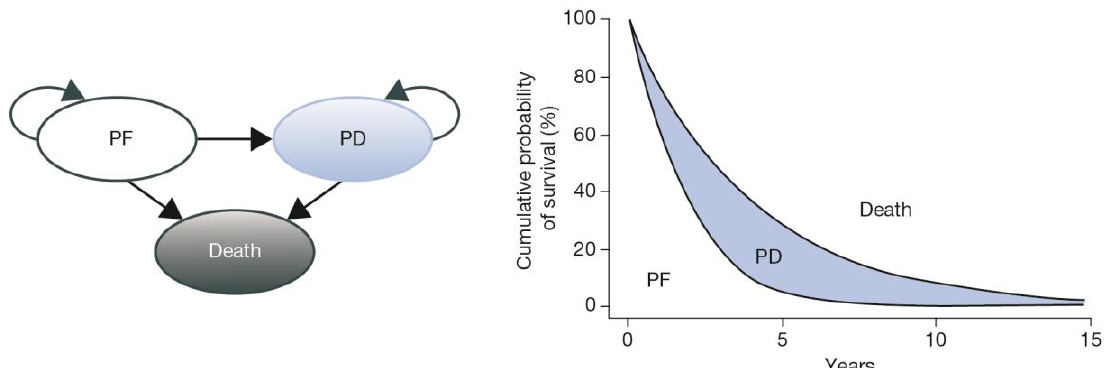
Figure 1: Health state structure of the economic model PD = progressed-disease; PF =